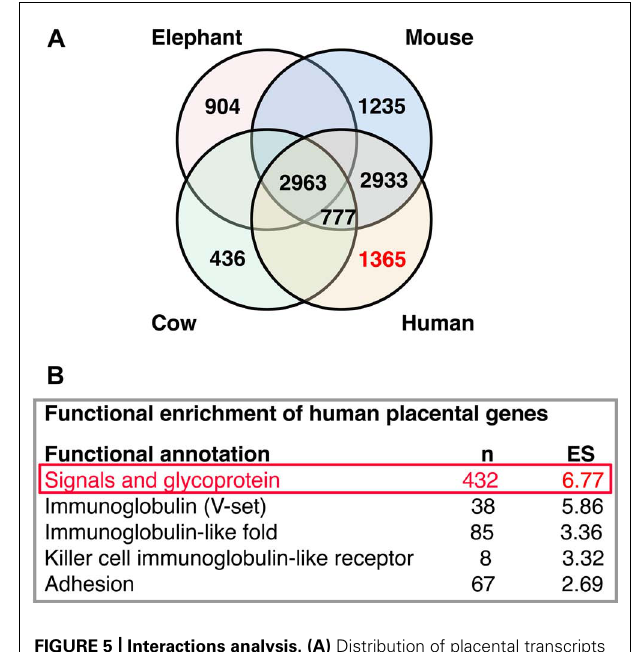
FIGURE 5 | Interactions analysis. (A) Distribution of placental transcripts obtained by Hou etal. (2012) and reproduced with permission. (B) Top five functional enrichments of human species-specific placental transcripts obtained by Hou etal. (2012) and reproduced with permission.The top one enriched module (in red) was further analyzed in Figure 6